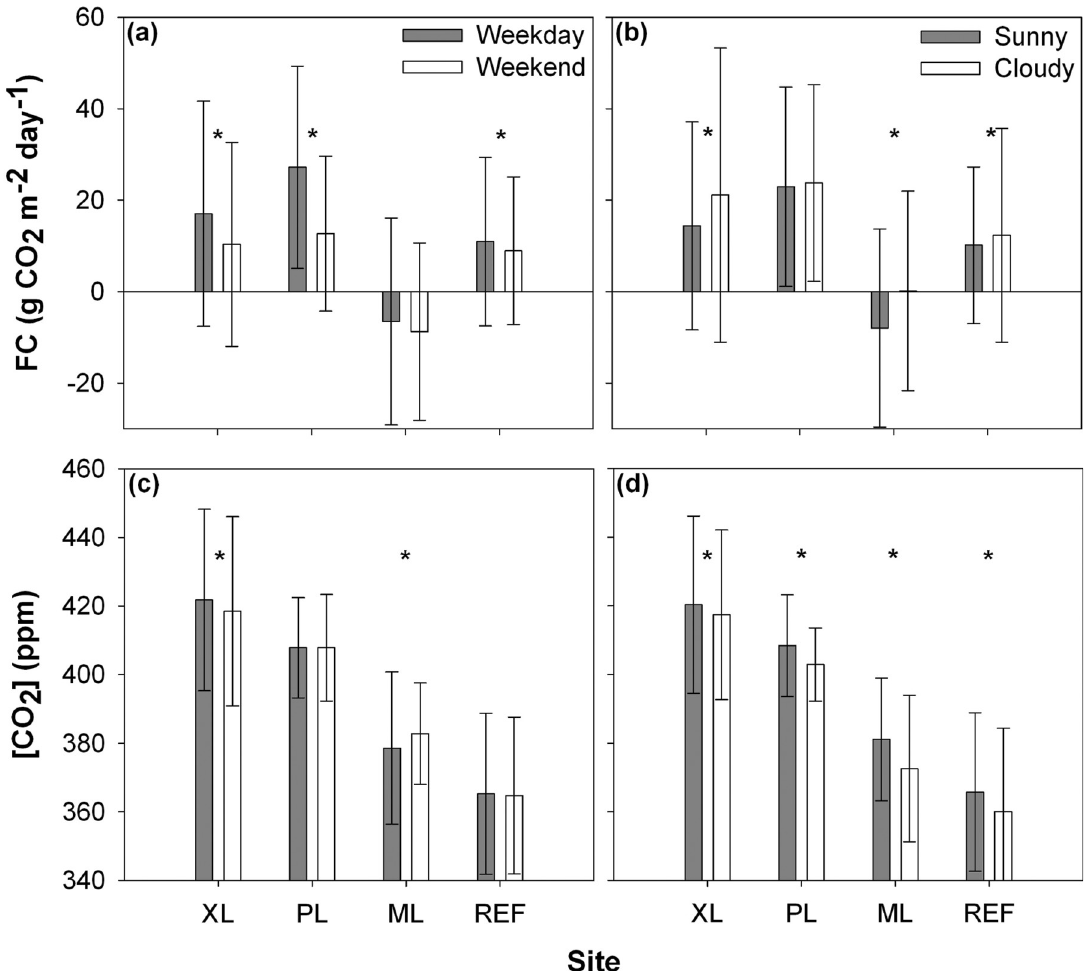
Fig 8. Average comparison between weekdays and weekends and sunny and cloudy days. Average values (bars) and standard deviations (error bars) of CO 2 flux and concentrations for (a, c) weekday and weekend, and (b, d) sunny and cloudy days for the XL, PL, ML, and REF sites. Stars indicate significant differences within each site ( p �